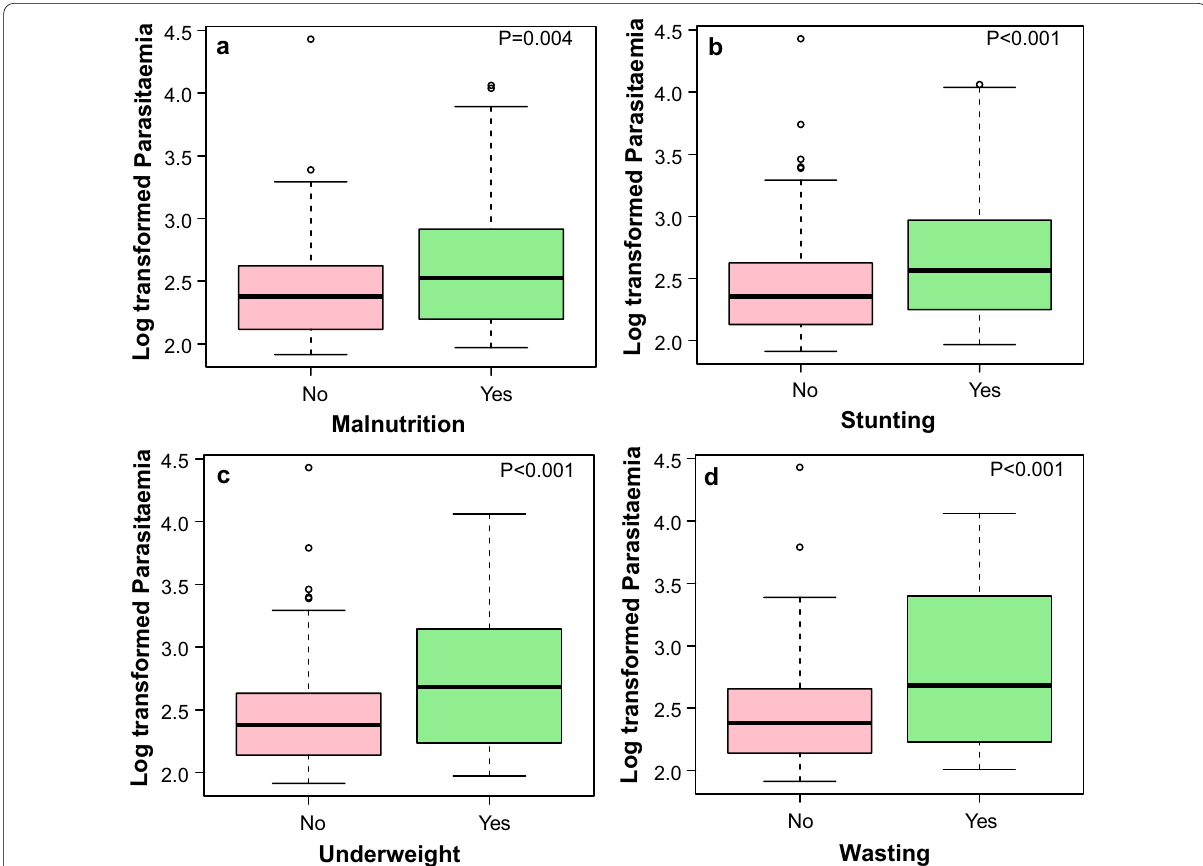
Fig. 4 Mean log transformed parasite density as affected by a malnutrition, b stunting, c underweight, and d